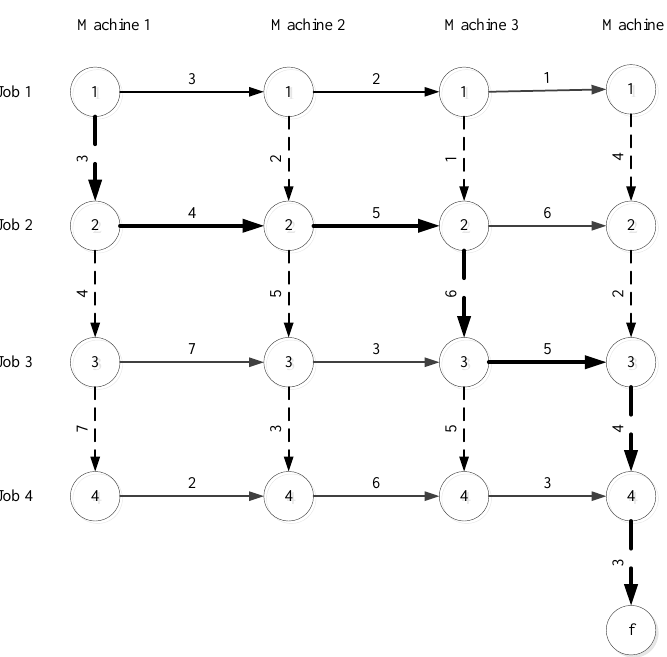
Figure 1. A sample 4-job 4-machine Permutation Flow-shop Scheduling Problem (PFSP) problem, with the permutation of (1,2,3,4) of jobs leading to the solution value of